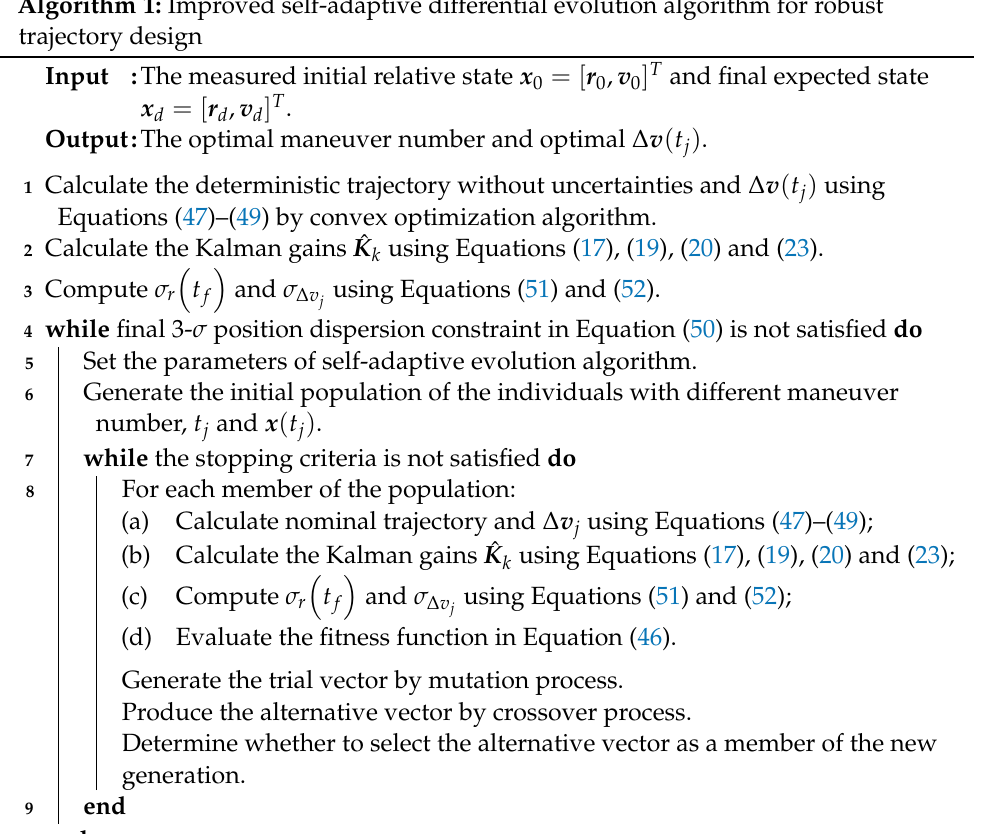
Algorithm 1: Improved self-adaptive differential evolution algorithm for robust trajectory